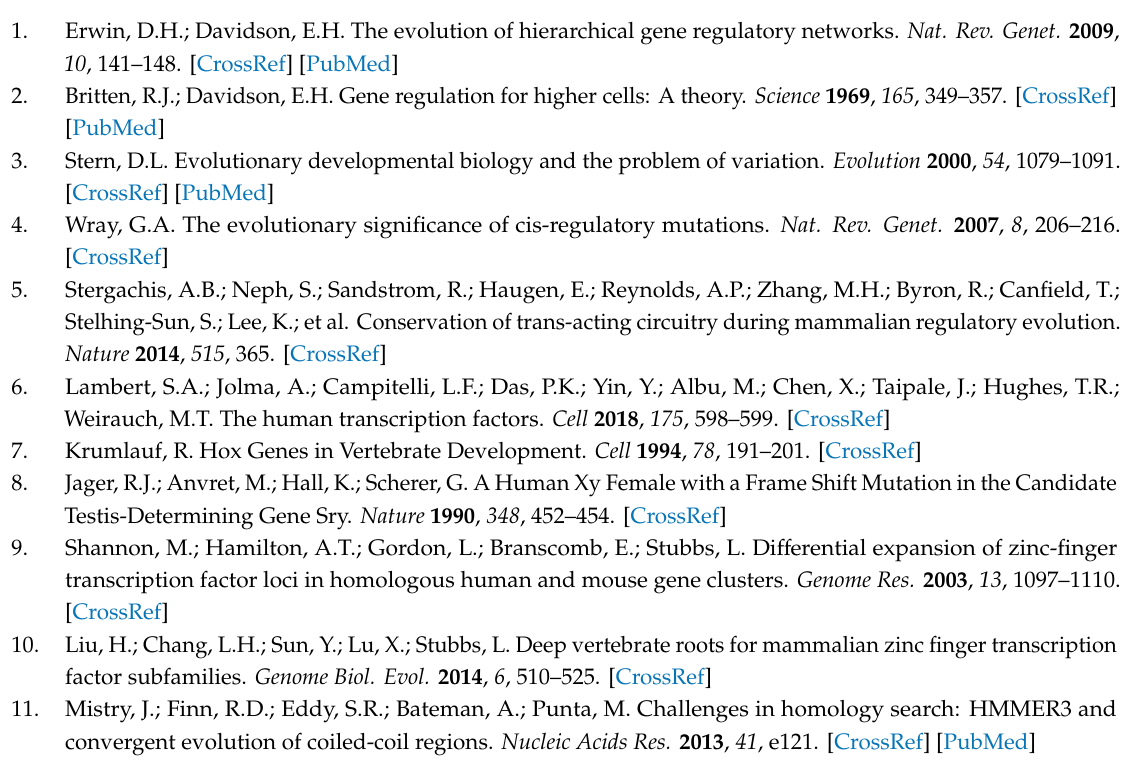
of human SHOX. Figure S1: Human TF-to-TF network that shows interactions between transcription factors. Gray blocks are isolated TFs; the blue blocks are main-net TFs; lines are TF–TF interactions. Figure S2: Functional cartography of experimentally determined gene interactions. We characterized each gene in the human PPI network according to its within-module degree z -score ( z ) and participation coe ffi cient ( p ). Genes were classified into eight groups: (NA) those with no experimental interactions, (R1) ultra-peripheral nodes ( z < 2.5 and p < 0.05), (R2) peripheral nodes ( z < 2.5 and 0.05 ≤ p < 0.625), (R3) non-hub connector nodes ( z < 2.5 and 0.625 ≤ p < 0.8), (R4) non-hub kinless nodes ( z < 2.5 and p ≥ 0.8), (R5) provincial hubs ( z ≥ 2.5 and p < 0.3), (R6) connector hubs ( z ≥ 2.5 and 0.3 ≤ p < 0.75), and (R7) kinless hubs ( p ≥ 0.75). Figure S3: Total number of TFs in 96 mammalian species. The black bar is the total number of TFs in a species. The species trees are time trees from TimeTree. Figure S4: Shaping of species-specific phenotypes by species–specific TFs. The blue ellipse is orthologue TF and the orange ellipse is non-orthologue TF. Figure S5: Glycolytic pathway component ALDOA and its expression levels in humans and mice. (a) Initial steps of glycolytic pathway. White block: metabolite of pathway. Gray block: enzyme interacting with isolated TF. Orange block: enzyme interacting with non-orthologous TFs in human. (b) Expression of ALDOA. The blue bar is the expression of ALDOA in mouse. The orange bar is the expression of ALDOA in human. Figure S6: Enrichment analysis of gene ontology terms and pathways. (a) Enrichment analysis of gene ontology (GO) terms. X-axis: GO terms; Y-axis: percentage of genes in GO term. Orange bar: connected TFs and their interaction genes. Blue bar: isolated TFs and their interaction genes. (b) Enrichment analysis of pathways. X-axis: percentage of connected TFs and their interaction genes. Y-axis: percentage of isolated TFs and their interaction genes. Blue dot: